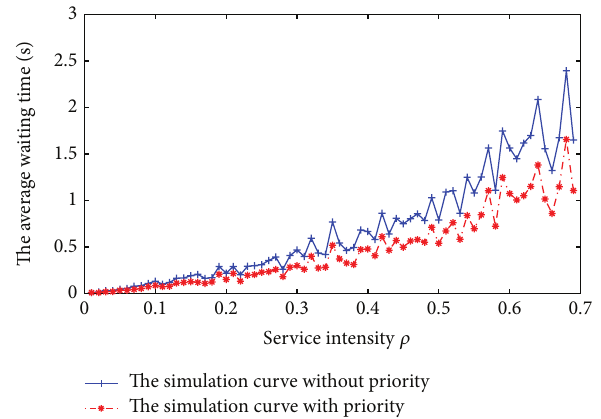
Figure 9: The curves of the average waiting time in the queuing models with priority and without